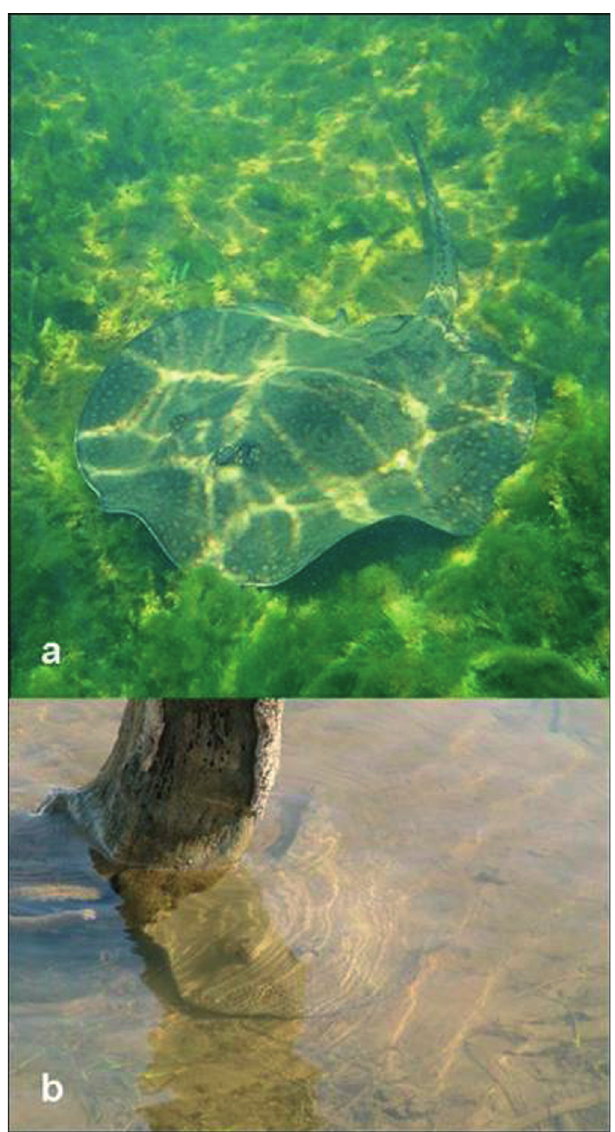
Fig. 1. Two hunting behaviors of potamotrygonid rays. Potamotrygon falkneri undulating its disc close to the bottom, stirring the substrate and uncovering hidden prey (a), and Potamotrygon orbignyi approaching a tree stump to pick snails adhered above water surface (not visible on the photograph) (b). The former species is from the study area mentioned in this paper, whereas the latter species was observed in the Maranhão River in Goiás State, Central